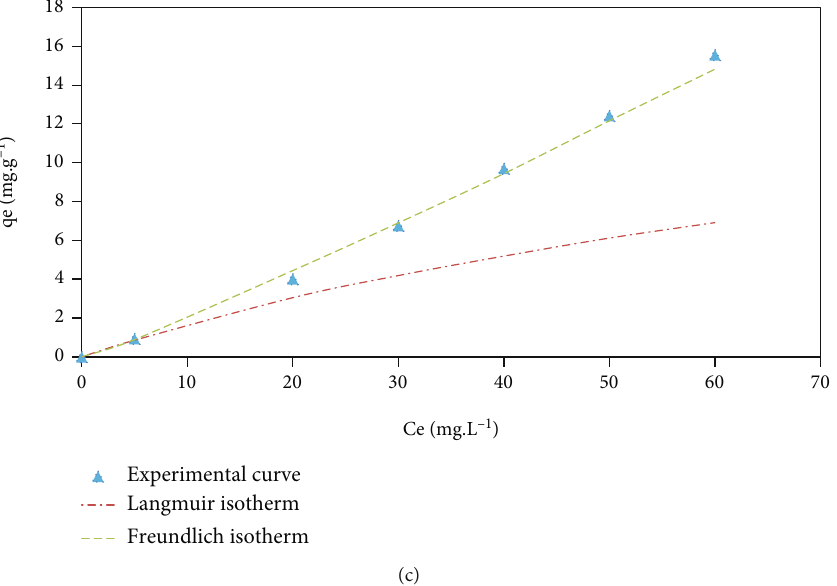
Figure 12: Plots of (a) Langmuir, (b) Freundlich, and (c) experimental data (at 20 ° C) for the adsorption of carmoisine onto ND. Table 6: Parameters of kinetic models applied in adsorption of the carmoisine at 20 ° C.